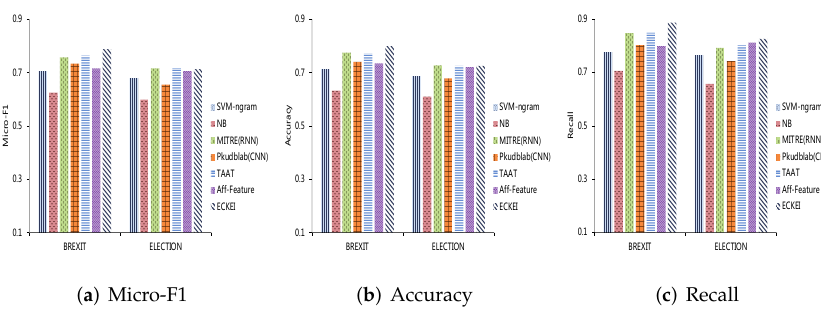
Figure 7. Micro-F1, accuracy and recall results on two datasets for the support stance.